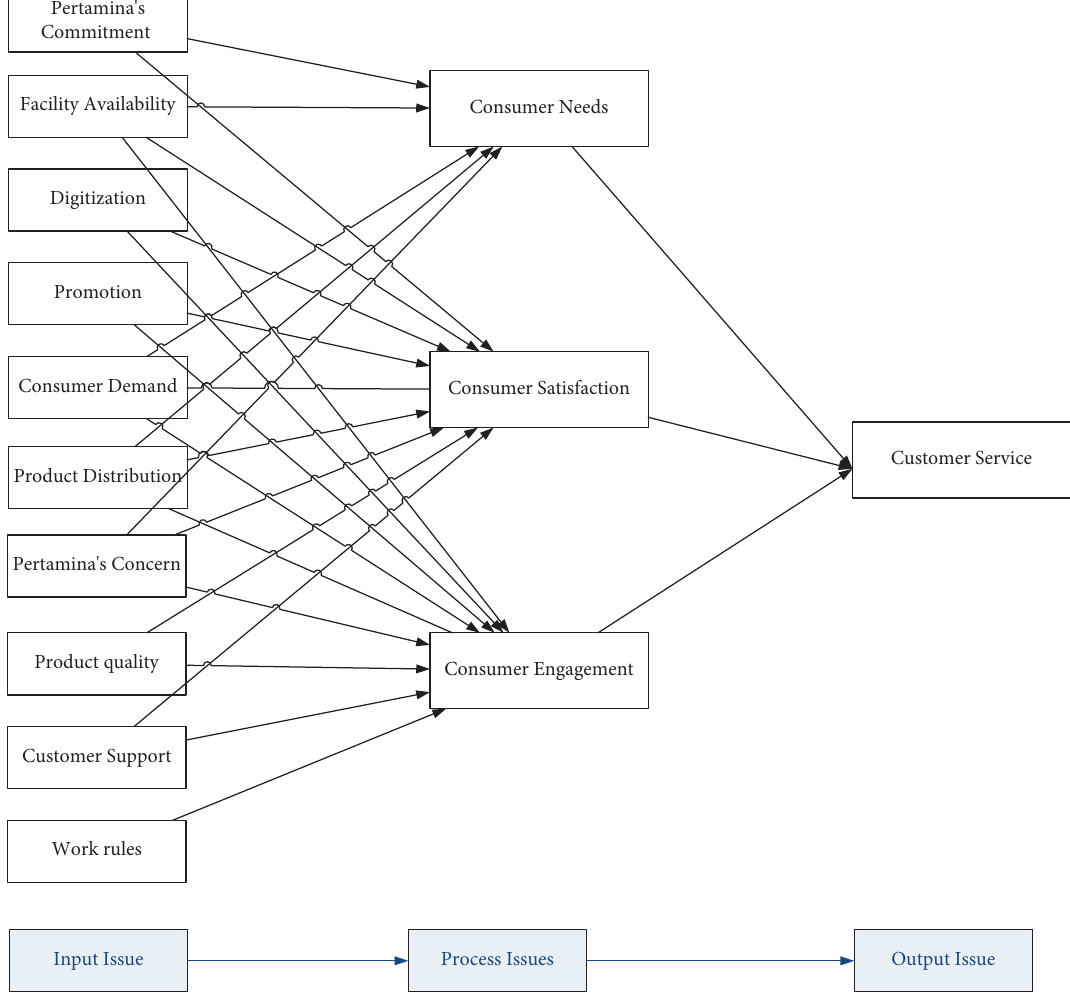
Figure 4: PT Pertamina’s consumer service segmentation